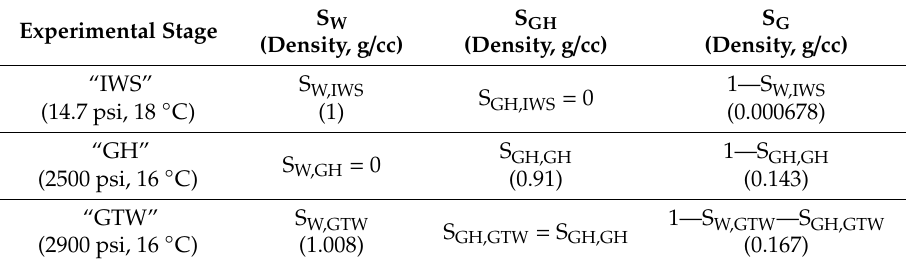
Table 1. Calculations for the saturation labeling in the three experimental stages: “IWS”, “GH” and “GTW”. Experimental